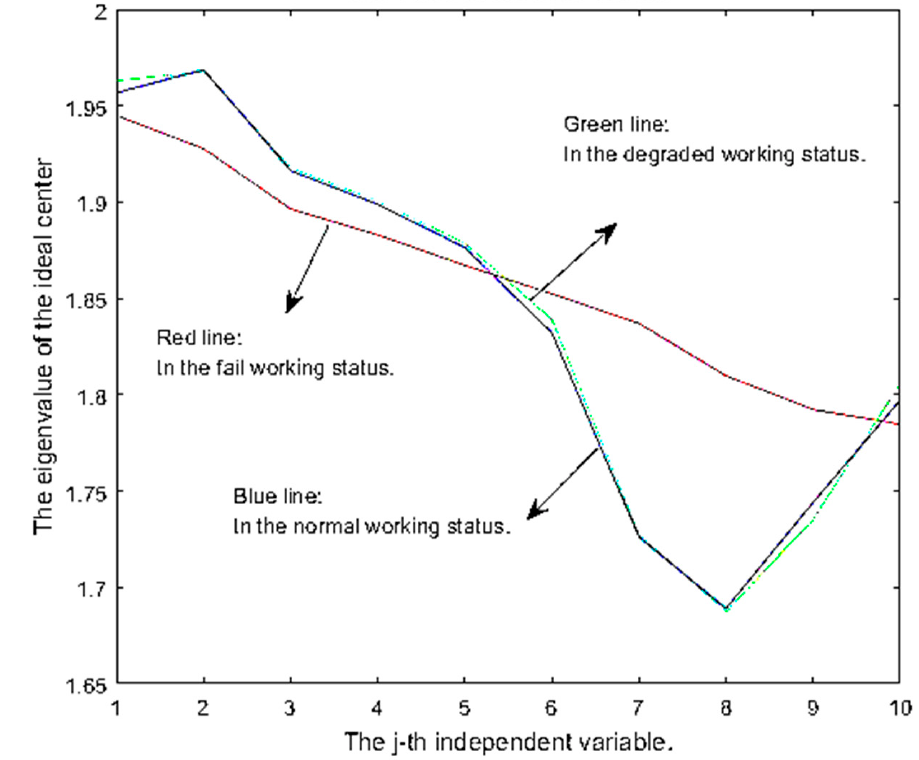
Figure 27. Three ideal systemic centers in the three working states of normal, deteriorated, and failure are obtained by dmkf2.